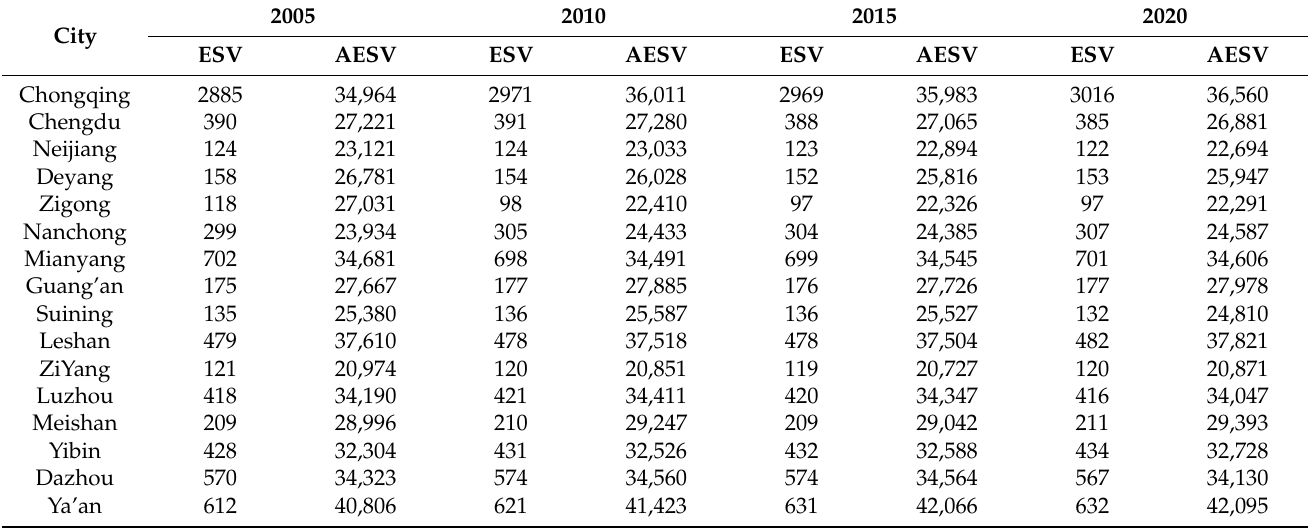
Table 7. Value of land ecosystem services and land-average value of land ecosystem services (units: billion CNY and CNY/hm 2 , respectively).